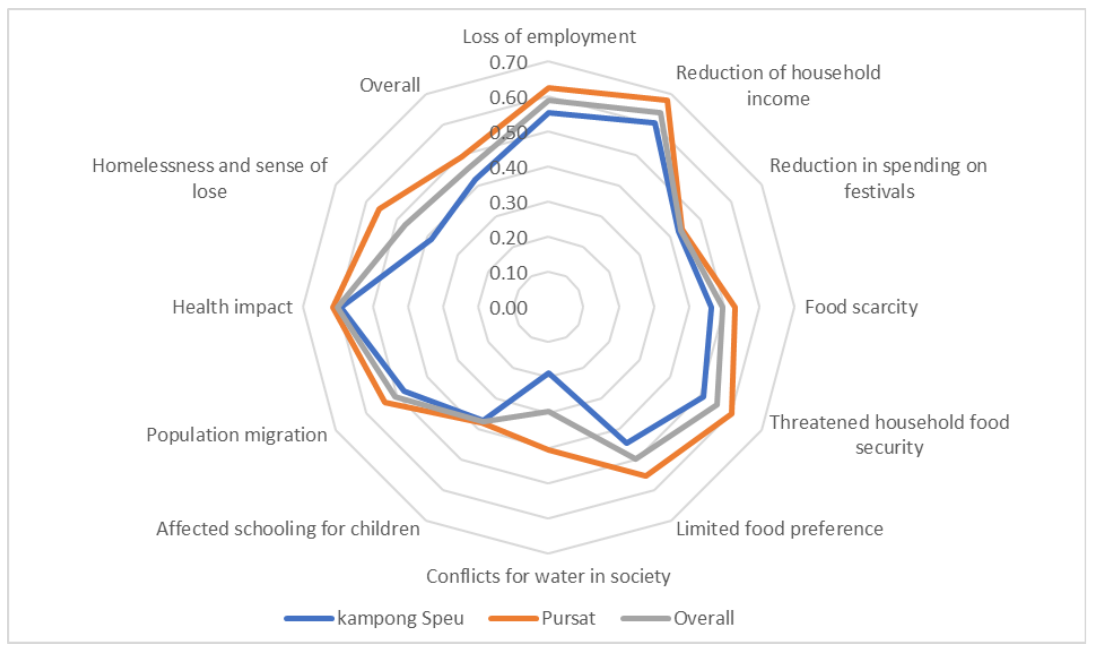
Figure 3. Impacts of drought on socio-economic development. Notes: WAI = the weight average index that is applied in order to be measured on a five-point scale (very low (VL) = 0.00–0.20, low (L) = 0.21–0.40, moderate (M) = 0.41–0.60, high (H) = 0.61–0.80, and very high (VH) = 0.81–1.00). OA = Overall assessment. p -value <0.05. p -value: The overall values for drought impacts = 0.000; loss of employment = 0.002; reduction in household income = 0.000; reduction in spending on festivals = 0.637; food scarcity = 0.005; threatened household food security = 0.000; limited food preference = 0.000; conflicts for water in society = 0.000; affected schooling for children = 0.735; population mi- gration = 0.012; health impact = 0.346; and homelessness and sense of loss = 0.000.